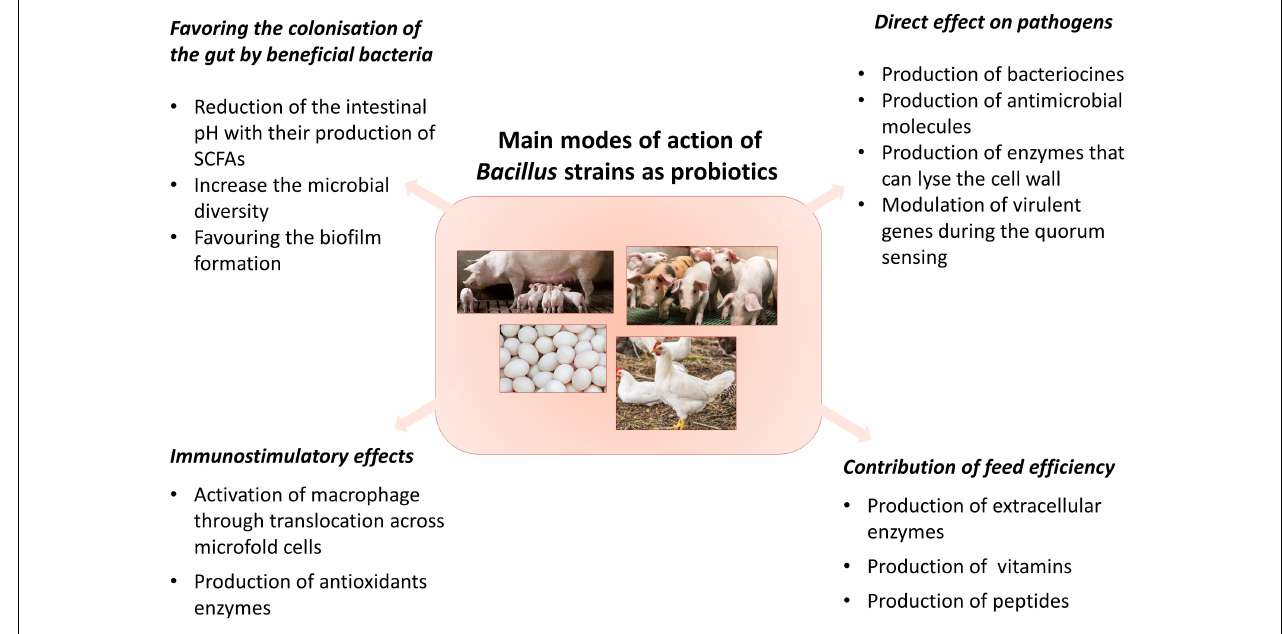
FIGURE 1 | Principal modes of action of Bacillus